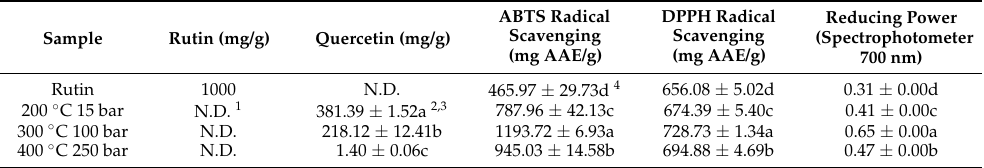
Table 1. Rutin, quercetin, ABTS, and DPPH radical scavenging activity and reducing power of rutin treated by different pressure and